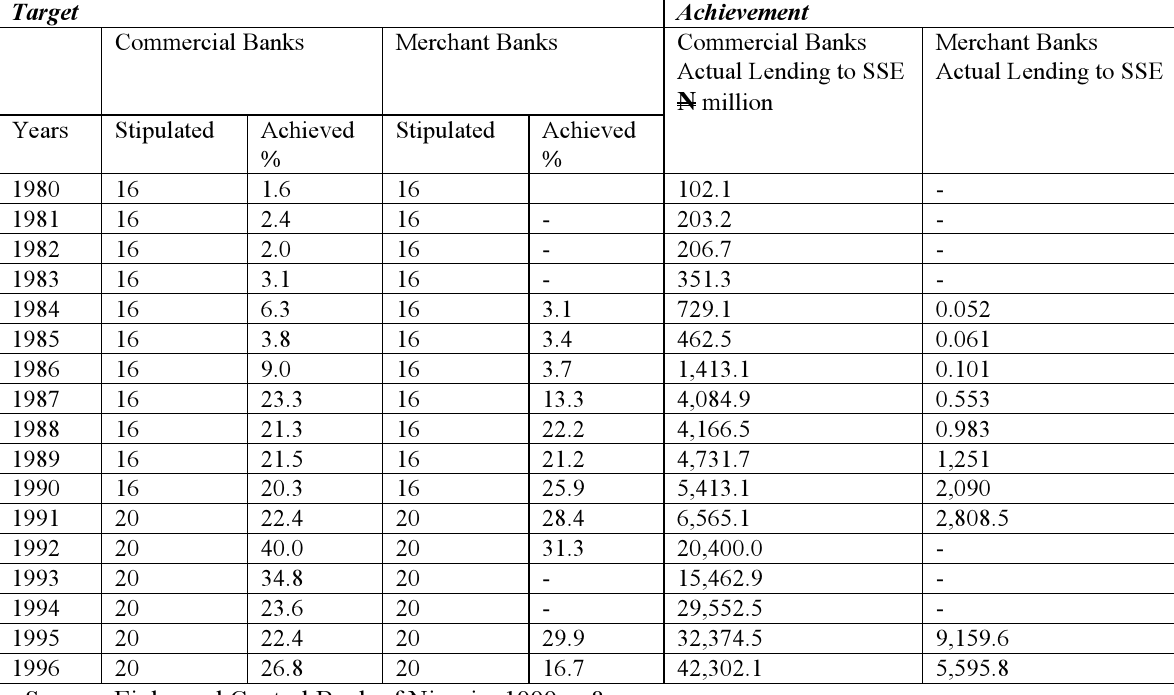
Table 8. Profile of Lending by Commercial and Merchant Banks 1980–1996